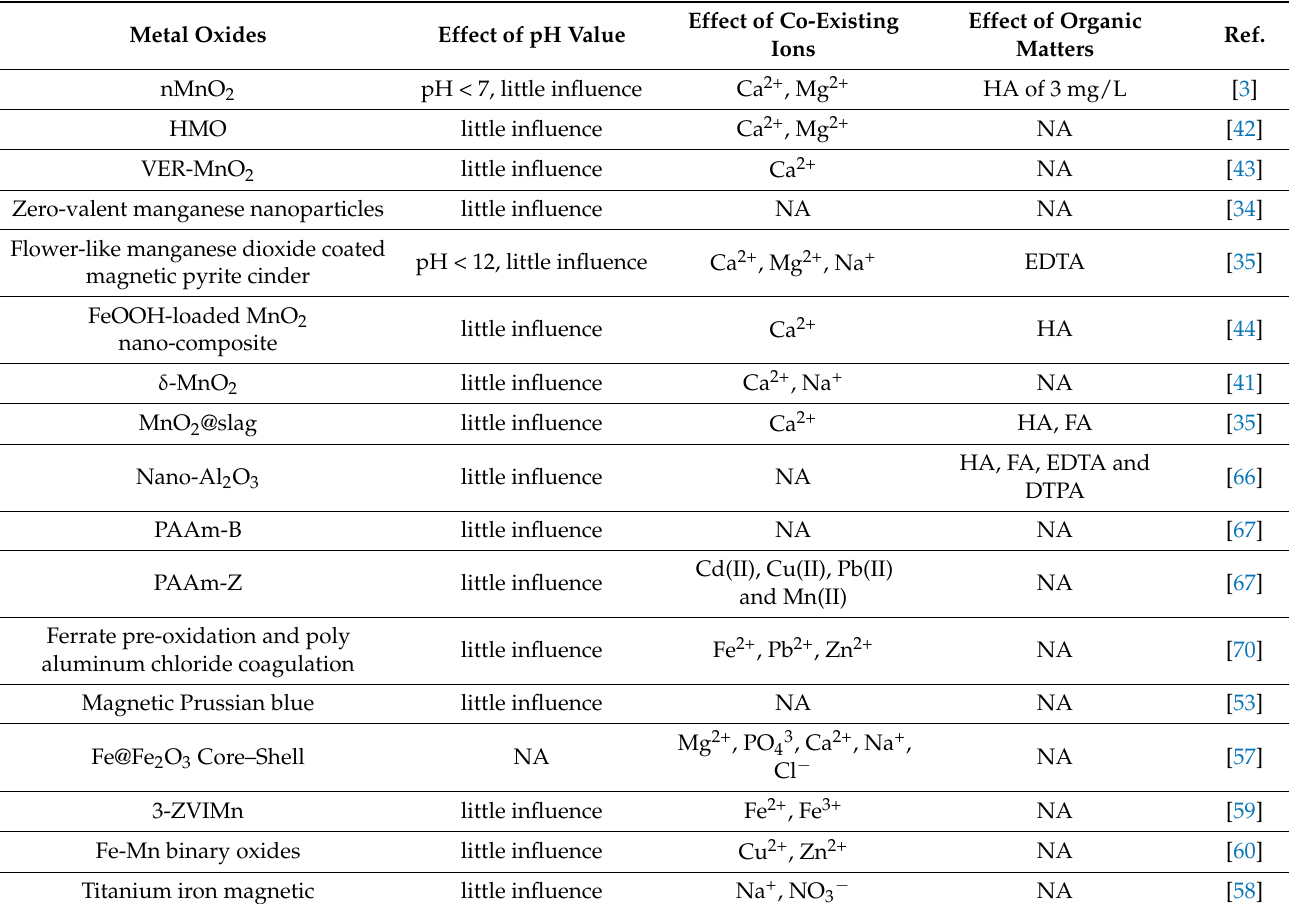
Table 5. Factors affecting the effectiveness of metal oxide